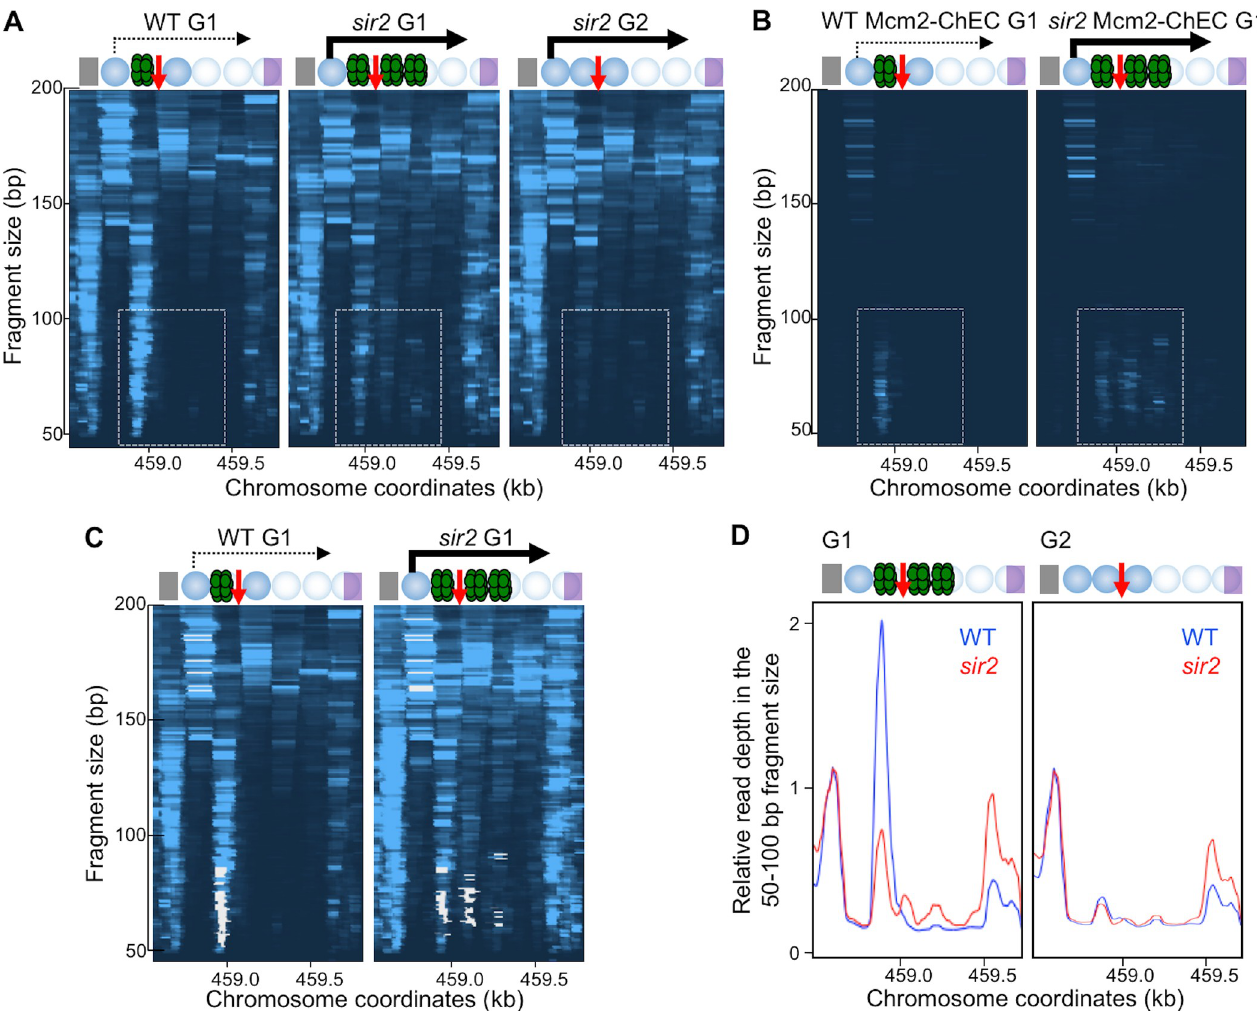
Fig 4. SIR2 deletion repositions Mcm2-7. A. MNase-seq analysis. WT (16535) and sir2 (16668) cells were arrested in G1 or G2 and processed as in Fig 2. B. Mcm2-MNase ChEC-seq analysis. G1-arrested, WT (WT) (16747) and sir2 (16769) mutant cells, whose endogenous copy of MCM2 was tagged with MNase, were permeabilized with digitonin, treated with calcium for 30 seconds to activate MNase, and then processed and plotted as in Fig 2. Dashed rectangles point to the area corresponding to the Mcm2-7 footprint. C. Composite of images in 4A and 4B, with 4B shown in white. D. Quantitation of read depths from fragments 50–100 base pairs long from WT (blue) (16535) and sir2 (red) (16668) cells arrested in G1 (left) or G2 (right) and otherwise treated as in Fig 2. Read depths were normalized to the read depth at the Reb1 binding site.